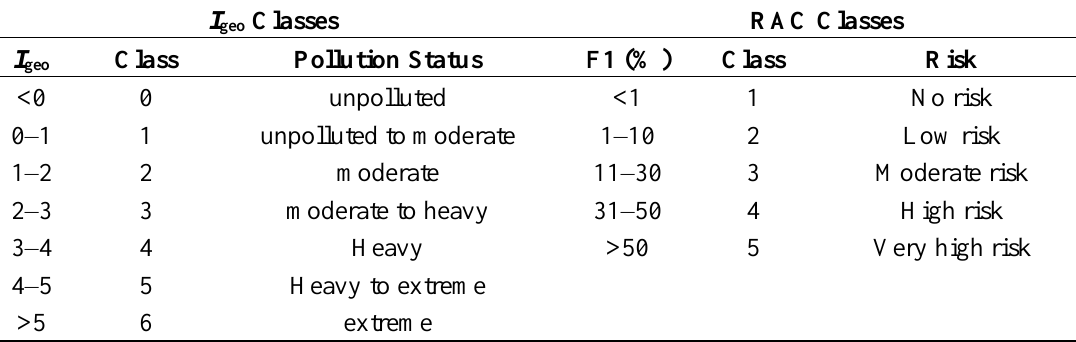
Table 1. Criteria for the accumulation index ( I geo ) and risk assessment code